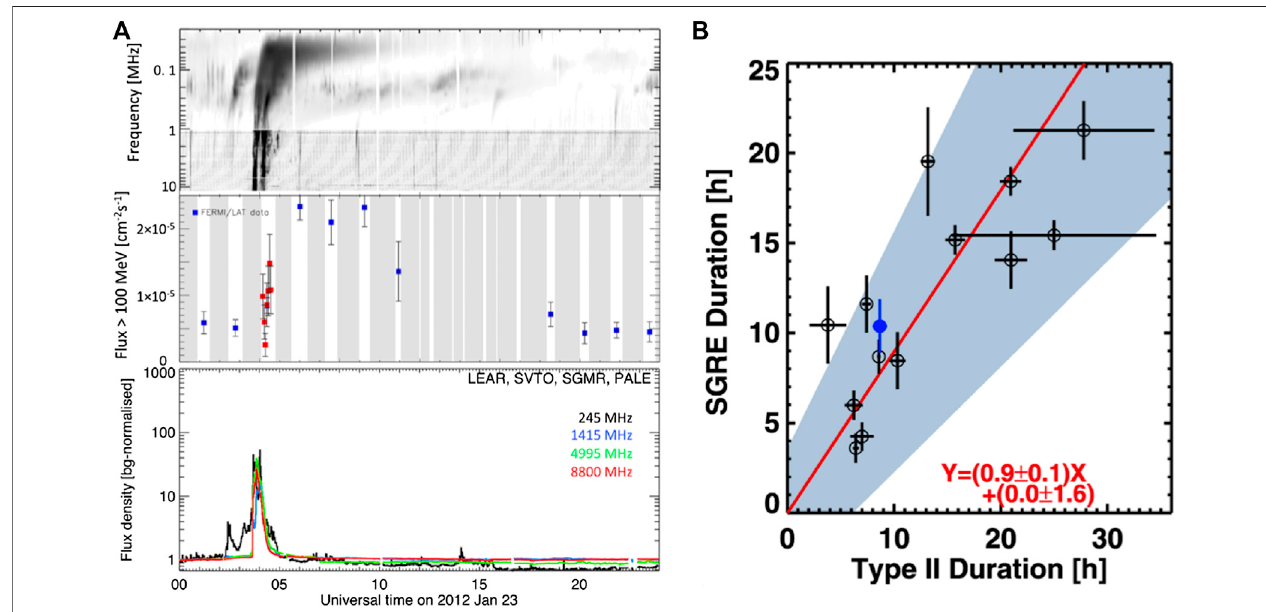
FIGURE 7 | Long-duration gamma-ray events with radio emission. (A) Dynamic radio spectrum (top) , with the frequency increasing from top to bottom, and gamma-ray light curve (middle) during 24 h (Klein et al., 2018), together with the light curves at selected radio frequencies (RSTN; bottom). (B) Scatter plot of the duration of pion-decay gamma-ray events vs the duration of decametric-to-kilometric type II bursts (Gopalswamy et al., 2018a). ©AAS. Reproduced with